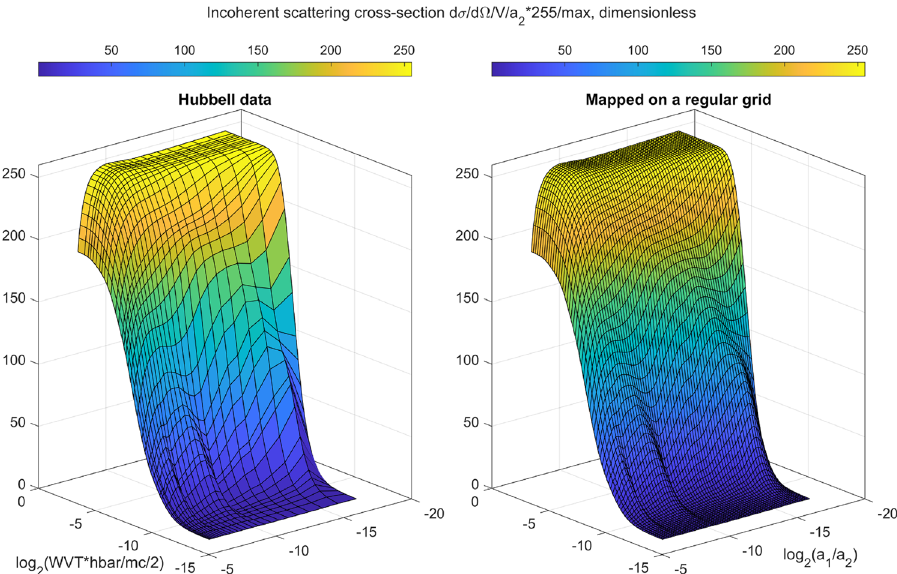
Figure 8. The map from MECT output ( a 1 , a 2 ) to the Compton scattering cross-section. The wavevector transfer is expressed in dimensionless units q (cid:31) / mc / 2 . Both inputs are on logarithmic axis of base 2 for quicker lookup using a regular 64x64 grid (right), obtained by interpolating Hubbell’s irregularly spaced data (left), available in Ref. 37 . The lookup table is normalized to the range [0, 255], so it can be stored as 8 bit integers, to reduce critical shared memory